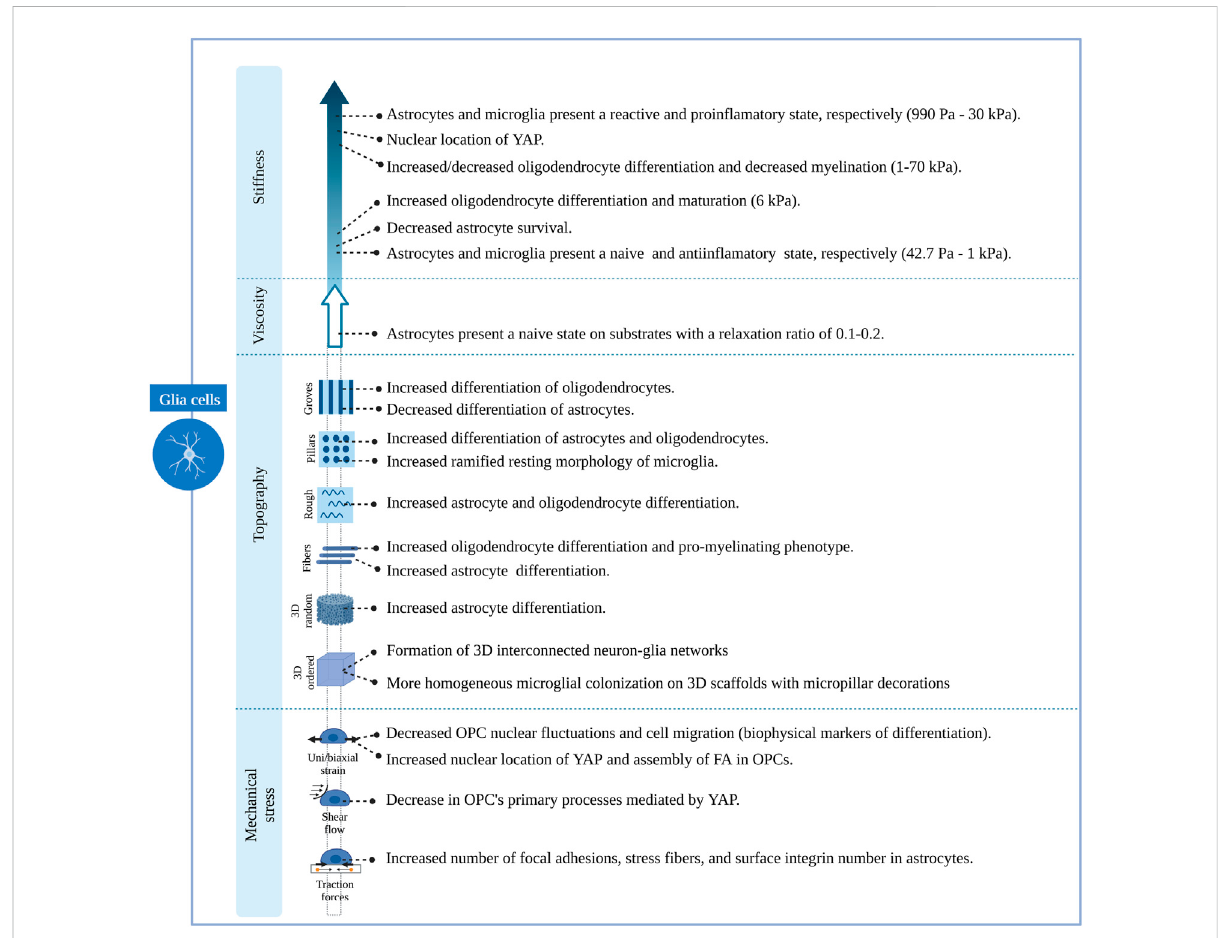
FIGURE 7 Overview of the effects induced by different features of engineered microenvironments on glial cells.